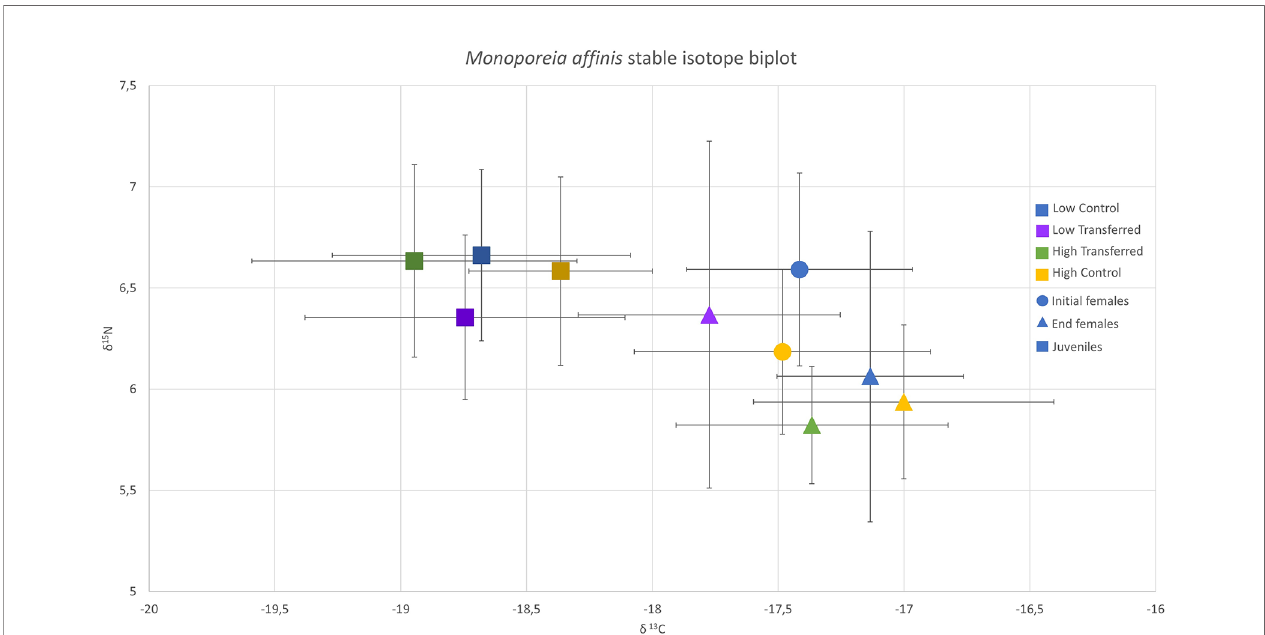
FIGURE 5 | Stable isotope biplot ( d 13 C and d 15 N) of Monoporeia af fi nis , in which the symbol represents the mean, and lines represent the standard deviation. Initial females are represented by circles, end of experiment females represented by squares, and juveniles (13-pooled individuals) are represented by triangles. See Figure 2 for experimental details.